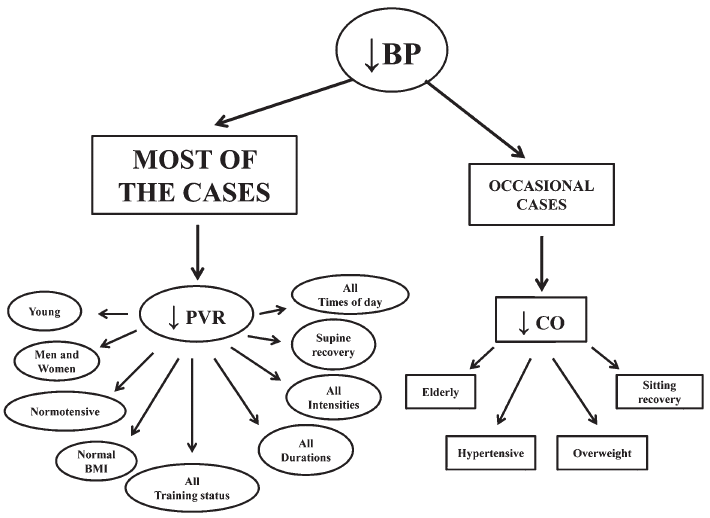
Figure 1. Schematic depicting the main findings of this review regarding the population and exercise protocol characteristics that may influ- ence hemodynamic determinants (CO: cardiac output; PVR: peripheral vascular resistance) of post-aerobic exercise